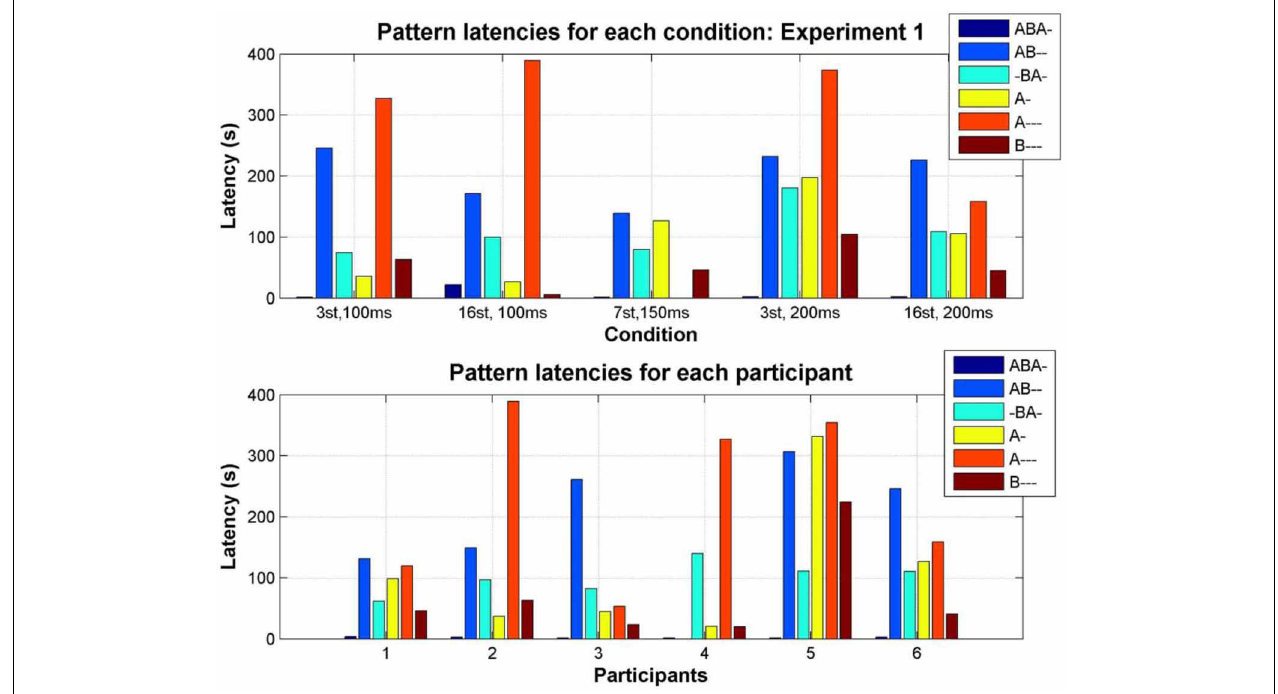
FIGURE 7 | Median latency of each pattern (color coded as indicated by the accompanying legend). Top: Median latency for the first report of each pattern in each condition, pooling all participants. Bottom: Median latency for the first report of each pattern by each participant, pooling all conditions.